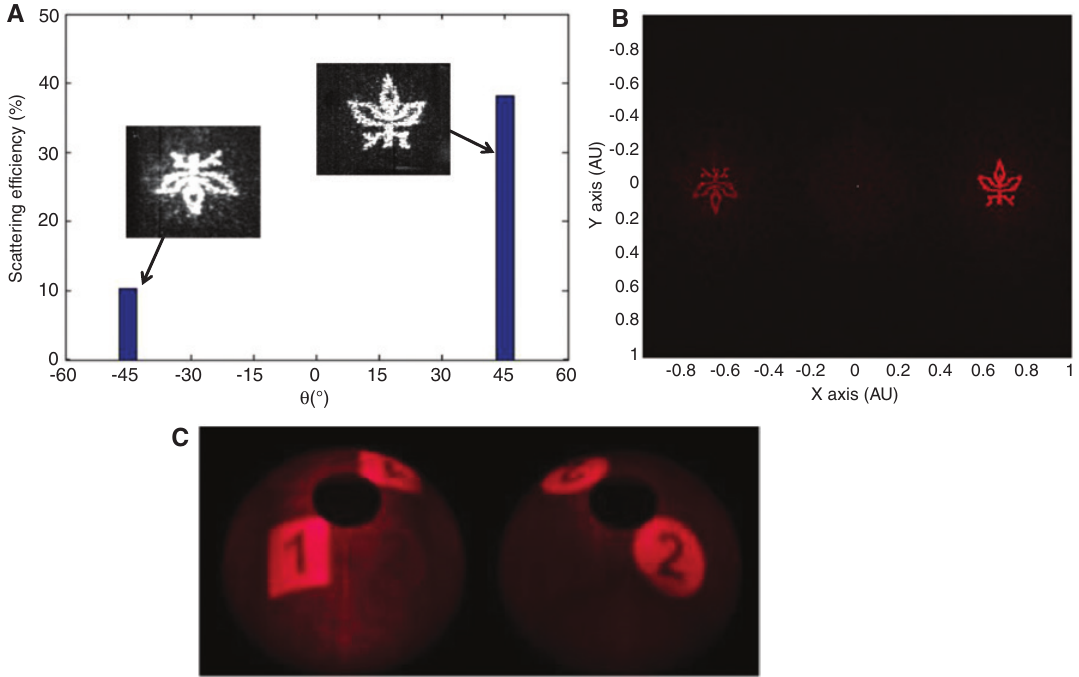
Figure 8: Ghost images in metasurface holograms: (A), (B) experimental observation and simulations. Adapted with permission from Ref. [23]. Copyright (2014) American Chemical Society; (C) experimental observation. Reprinted with permission from Ref. [52]. Copyright (2014) American Chemical